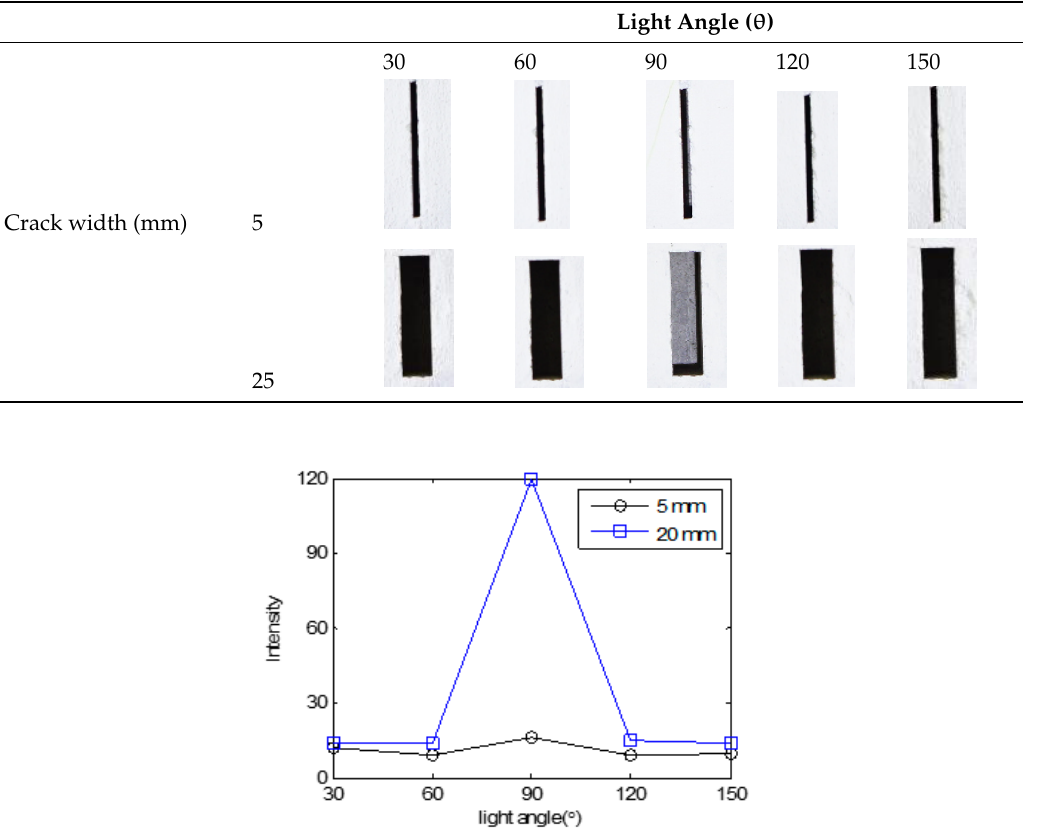
Figure B2. Variation in brightness of crack depending on light angle and crack width.